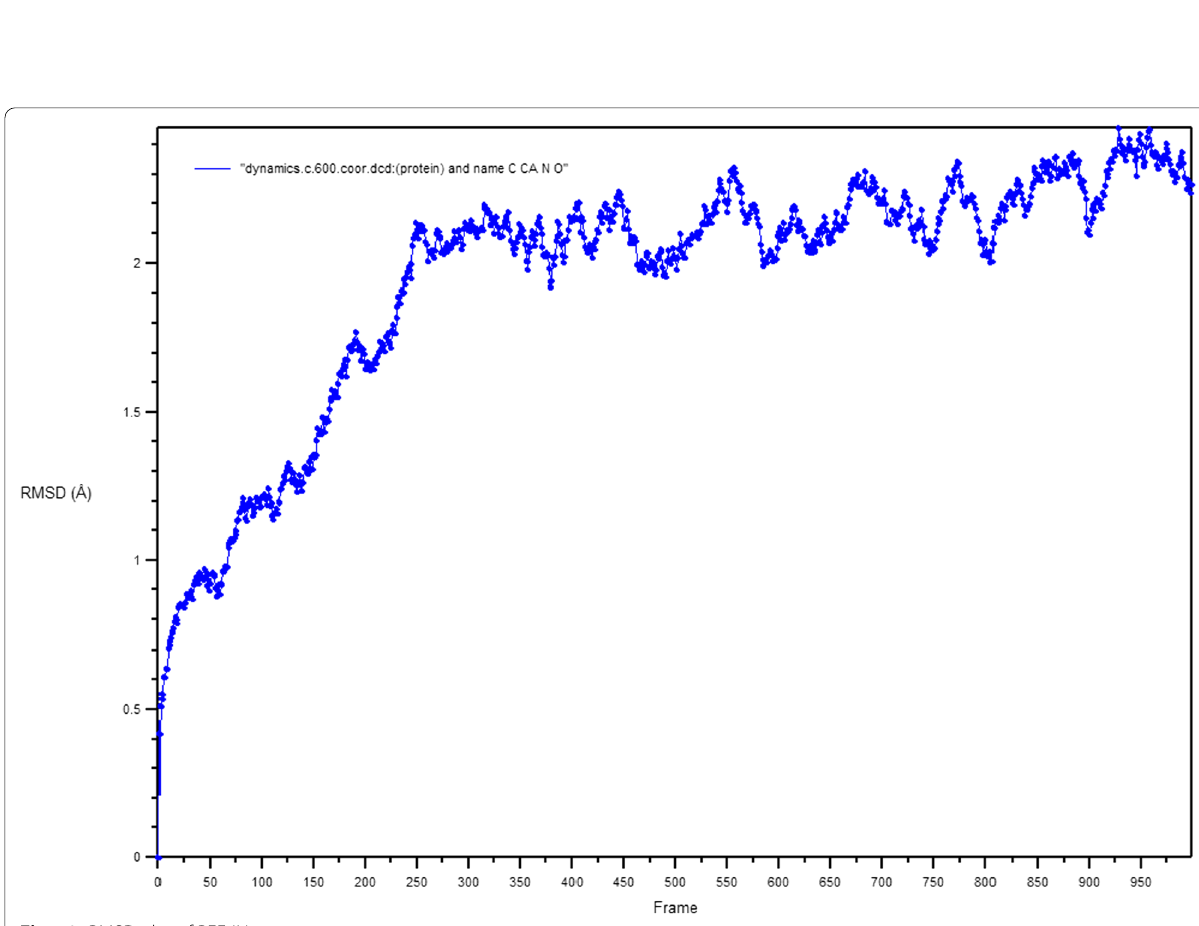
Fig. 12 RMSD plot of